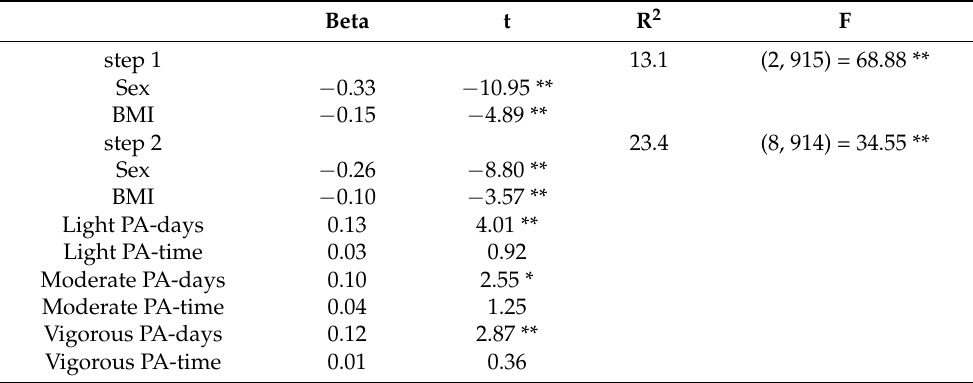
Table 4. Prediction of well-being from physical activity intensity, frequency and duration.